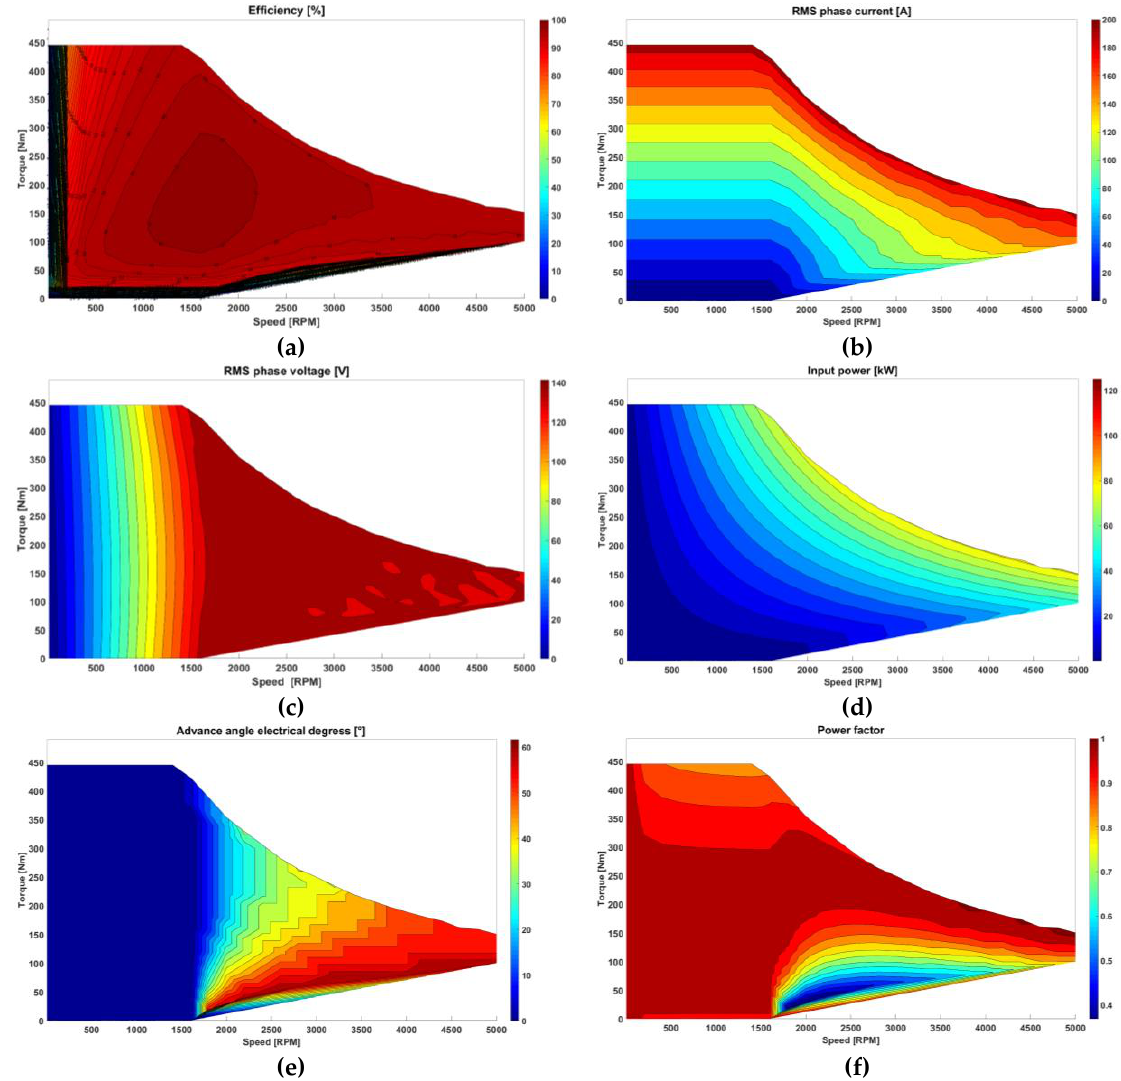
Figure 12. Calculated performance maps of the ERPMSM: ( a ) motor efficiency map; ( b ) RMS phase current map; ( c ) RMS phase voltage map; ( d ) input power map; ( e ) required advance angle map (in electrical degrees); and ( f ) power factor map.